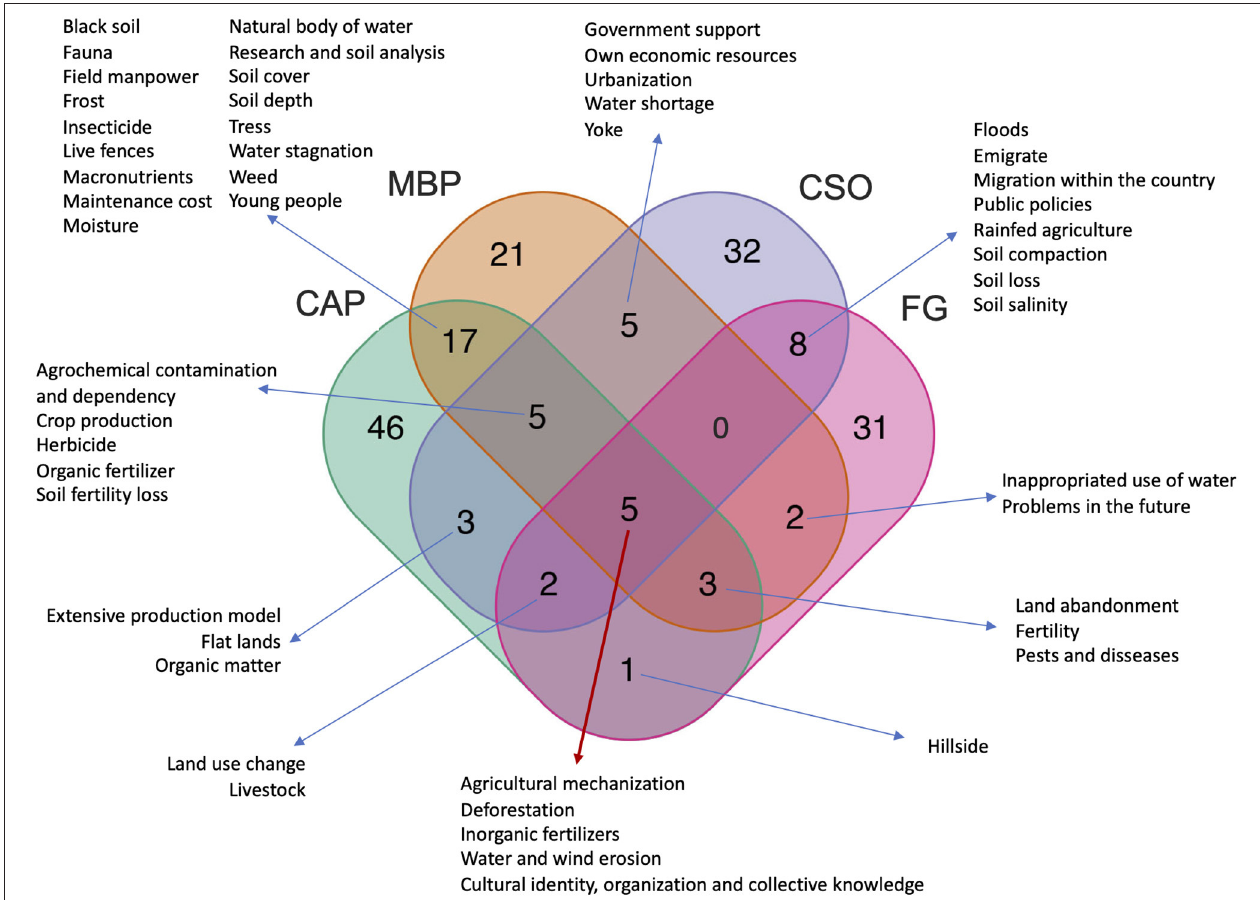
FIGURE 10 | Venn diagram showing the shared concepts between sectors and the five concepts shared among all of them (red